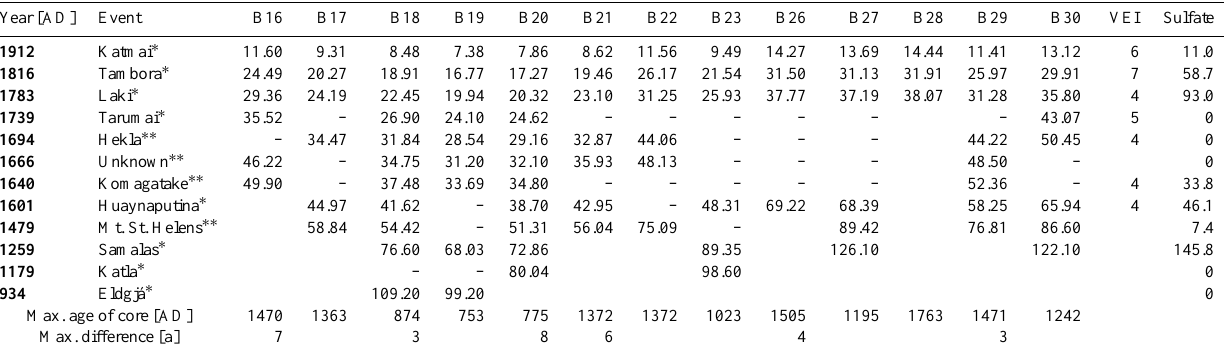
Table 2. Depth of volcanic horizons used for dating. The given year is the time of aerosol deposition on the Greenland ice sheet. All depths are given in meter water equivalent. If a horizon could not be clearly identified a dash is shown in the table. A field is empty if the horizon is deeper than the length of the ice core. The maximum difference is estimated from a comparison between cores dated by annual layer counting (Mieding, 2005; Schwager, 2000) and the dating used for this study. Also given are the volcanic explosivity index (VEI; Newhall and Self, 1982) and the total Northern Hemisphere stratospheric sulfate aerosol injection (Gao et al., 2008) for each volcanic eruption